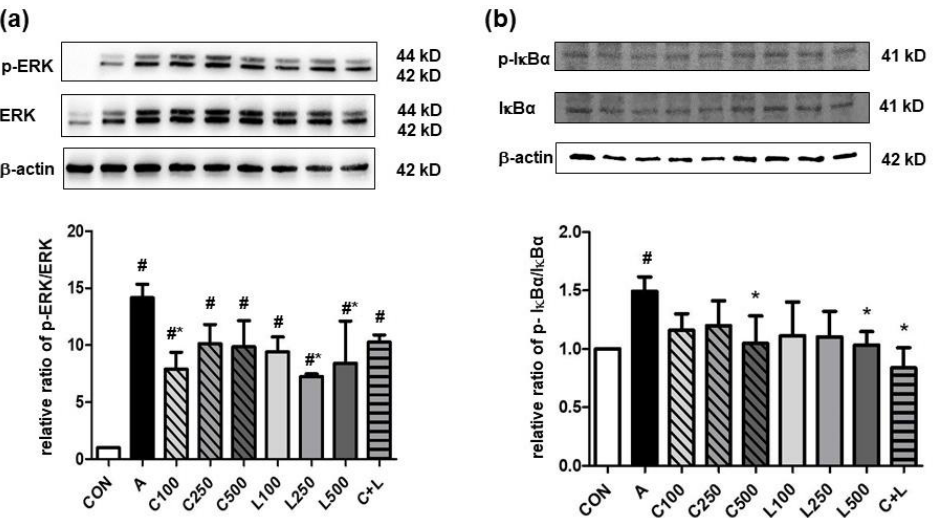
Figure 3. Effects of aspirin, CPC, and/or LBP on the relative ratio of ( a ) p-ERK/ERK ( n = 3) and ( b ) p-I κ B α /I κ B α ( n = 4). CON: control group, A: aspirin-induced group, C: CPC treated group, L: LBP treated group. Data are mean ± SD. # p < 0.05 compared with the CON group. * p < 0.05 compared with the A